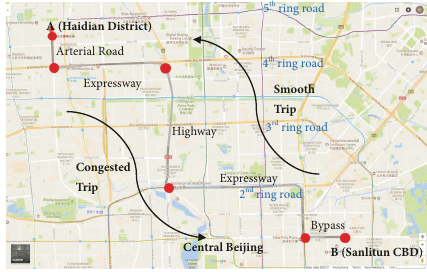
Figure 2: Map of the selected